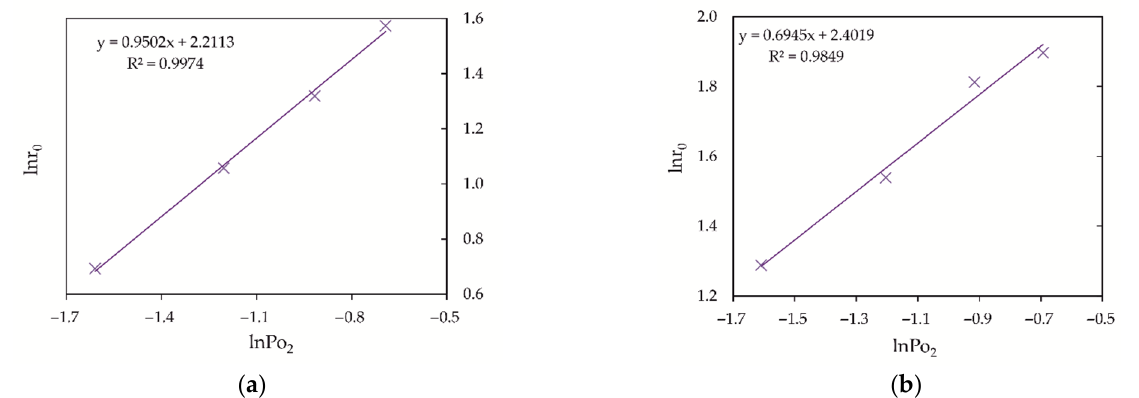
Figure 10. Dependence of lnr 0 on lnPo 2 without ( a ) and with ( b ) Cu (II). According to the data obtained, the reaction order relative to oxygen pressure was 0.95 for the H 3 AsO 3 -Fe 2+ -H 2 SO 4 and 0.69 for the H 3 AsO 3 -Fe 2+ -Cu 2+ -H 2 SO 4 system (Figure 10a,b, respectively). Introduction of Cu (II) ions into the solution led to a decrease in the partial order and, hence, to a decreased dependence of the process on oxygen pressure. A graphical determination of the partial order relative to the concentration of As (III) ions is shown in Figure 11a,b. The experimental reaction order relative to the initial concentration of As (II) ions was 0.46 for the H 3 AsO 3 -Fe 2+ -Cu 2+ -H 2 SO 4 system and 0.48 for the H 3 AsO 3 -Fe 2+ -H 2 SO 4 system.